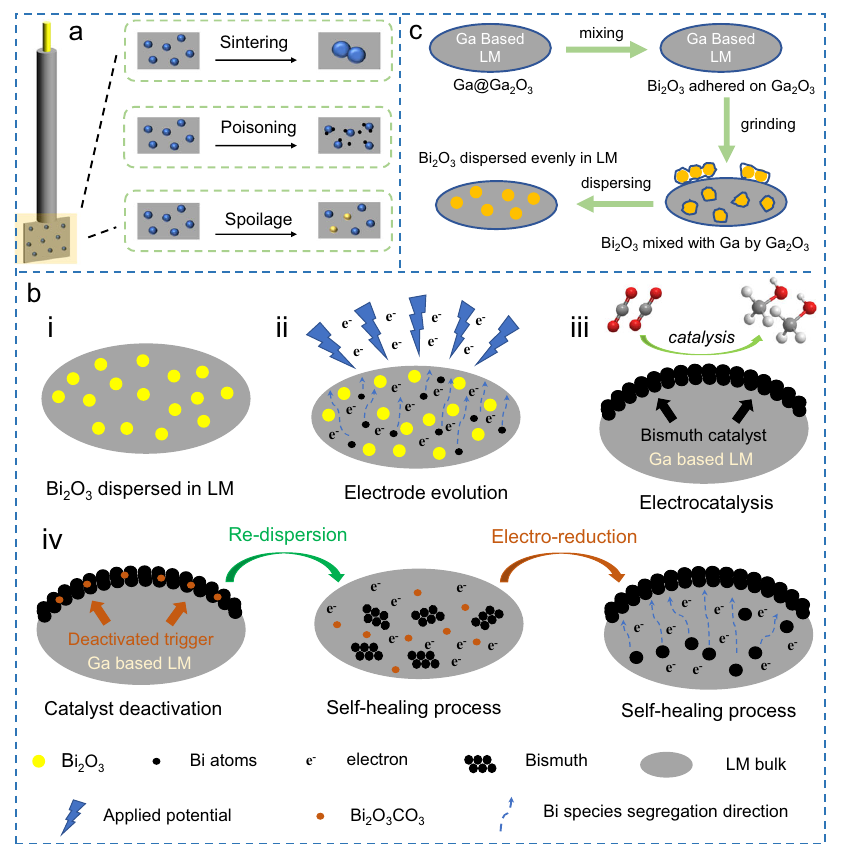
Fig. 1 | Schematic diagram of traditional electrode deterioration mechanism and the preparation and healing mechanism of the liquid metal electrode. a Schematic diagram of the deterioration mechanism for conventional elec- trodes, including sintering, poisoning, and spoilage in sequence. b Schematic diagram of LM electrode in different states or processes. i Bi 2 O 3 dispersed